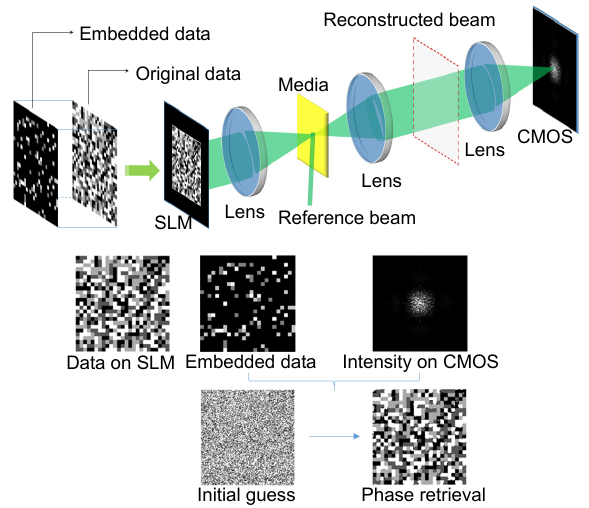
Fig. 9 | The diagram of non-interferometric system for phase retrieval based on IFT algorithm.